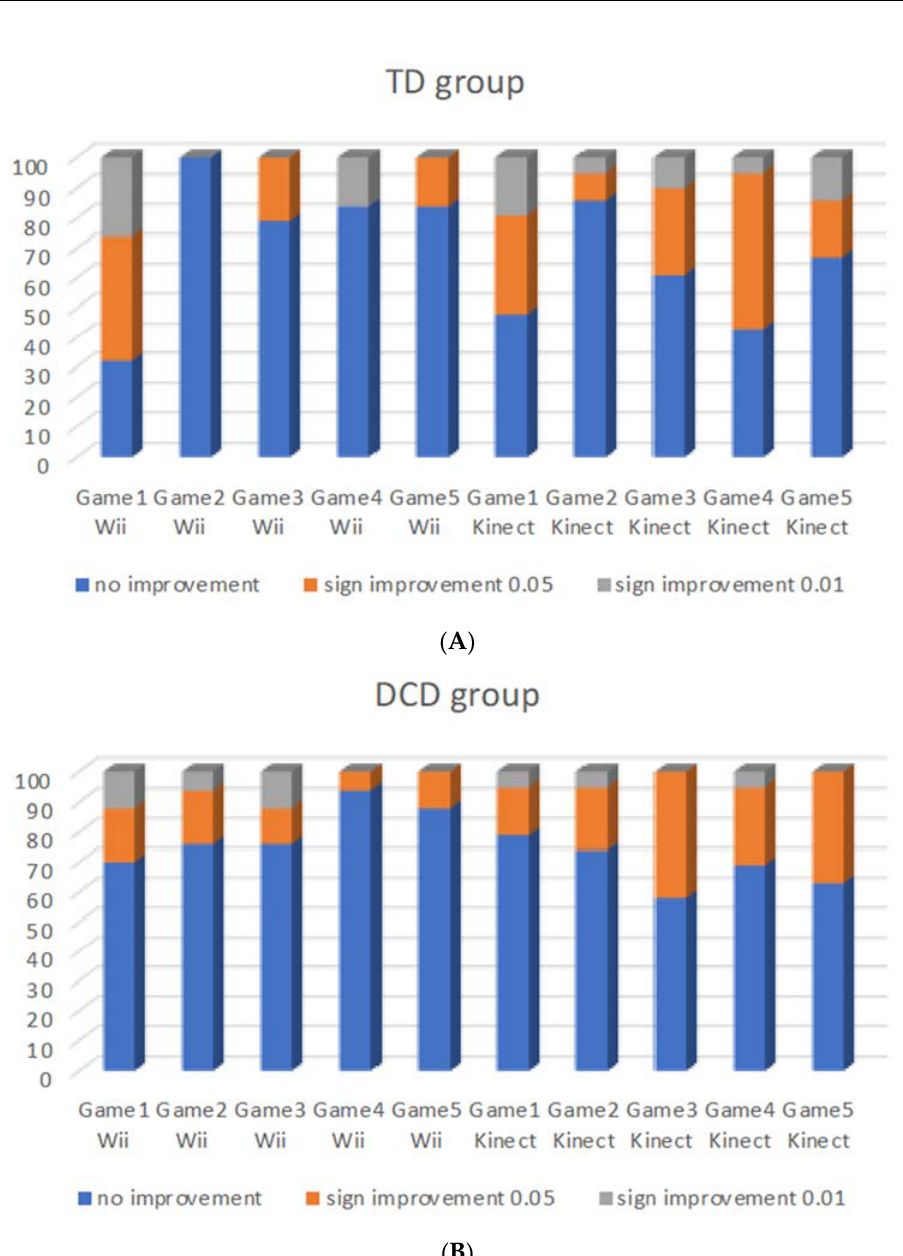
Figure 3. ( A ) (TD group) and ( B ) (DCD group). Individual classification of level of significant improvement within each game over five weeks in the TD group per console (Game 1 Wii = soccer heading; Game 2 Wii = Table tilt; Game 3 Wii = Ski jump; Game 4 Wii = Balance bubble; Game 5 Wii = Penguin slide; Game 1 Kinect = River rush; Game 2 Kinect = Rally ball; Game 3 Kinect = 20,000 leaks; Game